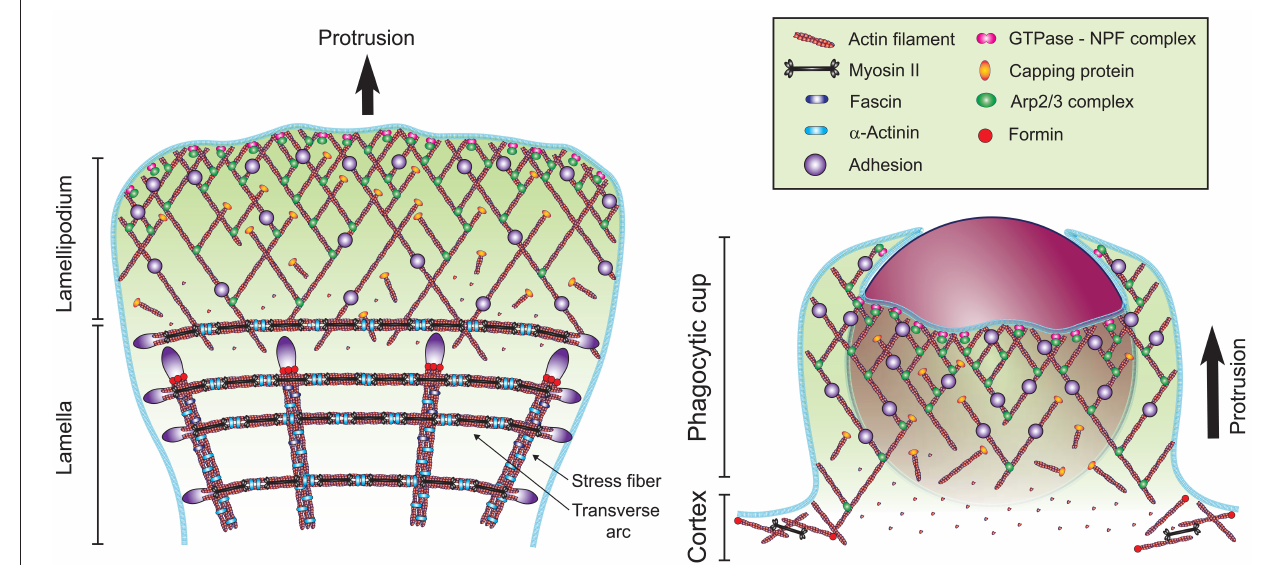
FIGURE 5 | Models of the actin cytoskeleton organization at the front of a migrating cell and at the phagocytic cup. The formation of a branched network of actin filaments (red) is mediated by the Arp2/3 complex (green ellipse), which is activated at the plasma membrane by an NPF recruited by an active Rho GTPase (pink double-circle). Actin dynamics are regulated by capping proteins (orange ellipse), elongation factors, debranching, severing, and monomer binding proteins (not represented for clarity). Formation of linear actin structures, such as the stress fibers and transverse arcs at the lamella involve the bundling proteins α -Actinin (light blue rod) and Fascin (dark blue rod), actin nucleation by formins (red circle) and Myosin II mini-filaments (black dumbbell). These actin structures are stabilized on the substratum by adhesions (purple). At the phagocytic cup, adhesions are mediated by Fc γ receptors, β 2 integrins or other phagocytic